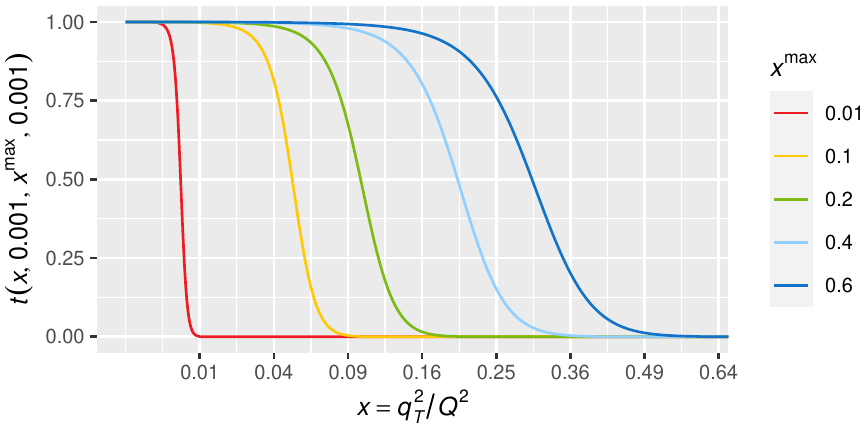
Figure 1. The transition function defined in (2.9) for different values of the parameter x max which determines the position of the transition. The x -axis is displayed on a square-root scale to guide the eye on the quadratic q T